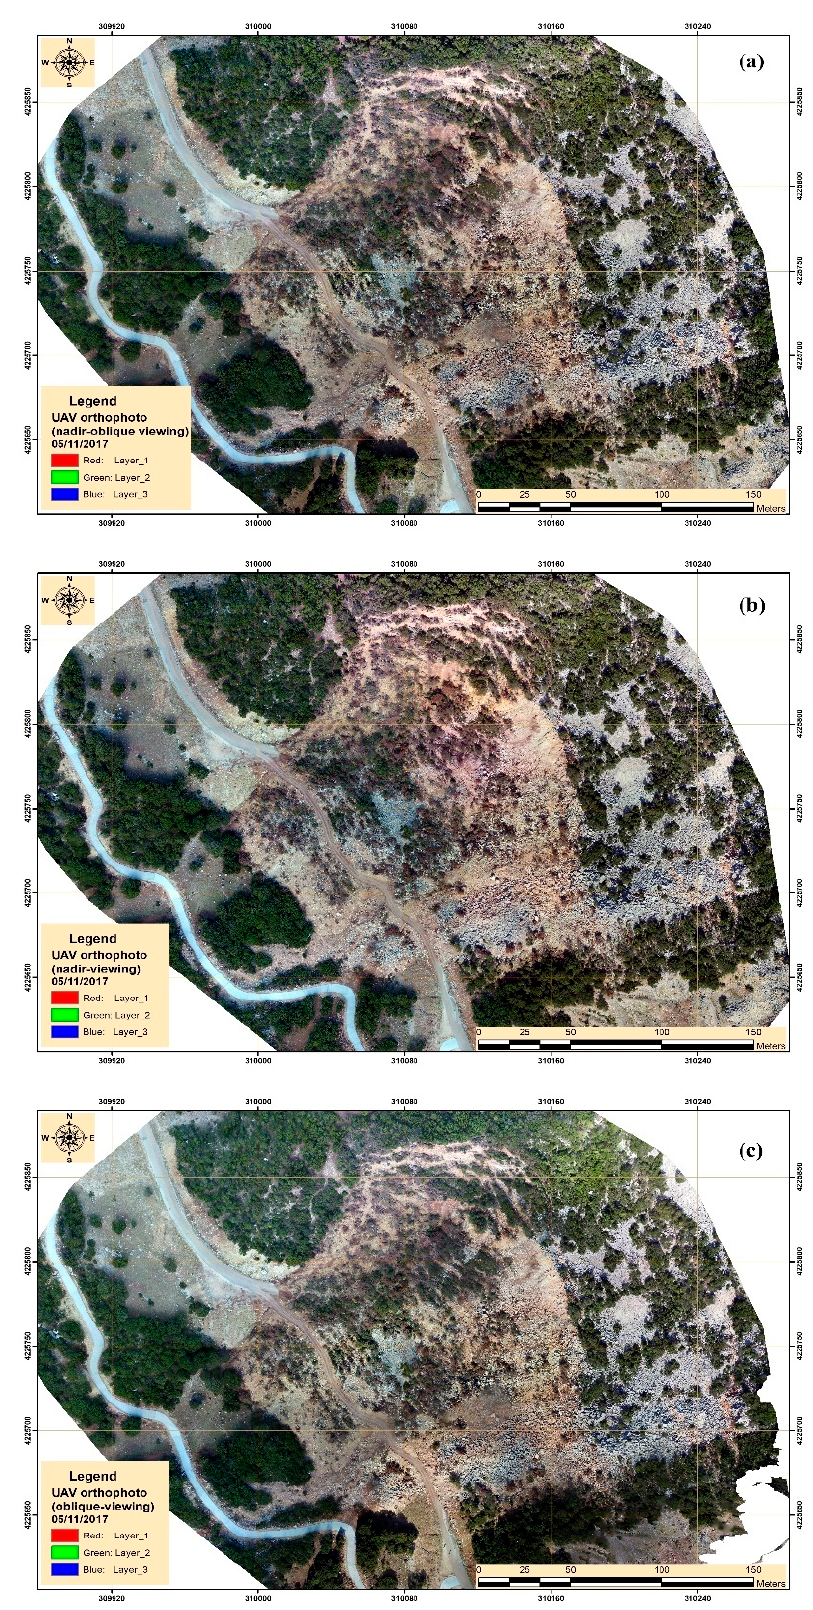
Figure 6. Orthophotos of the study area. ( a ) Orthophoto from a combination of nadir and oblique im- agery on 5 November 2017. ( b ) Orthophoto from nadir imagery on 5 November 2017. ( c ) Orthophoto from oblique imagery on 5 November